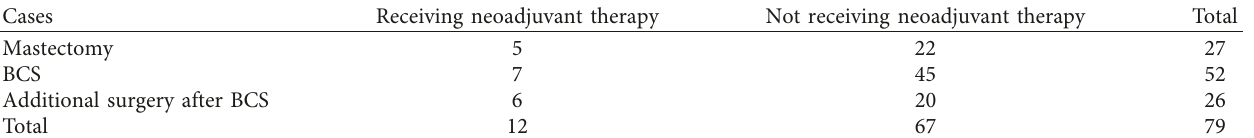
Table 3: Surgical procedures performed in patients who received and did not receive neoadjuvant.